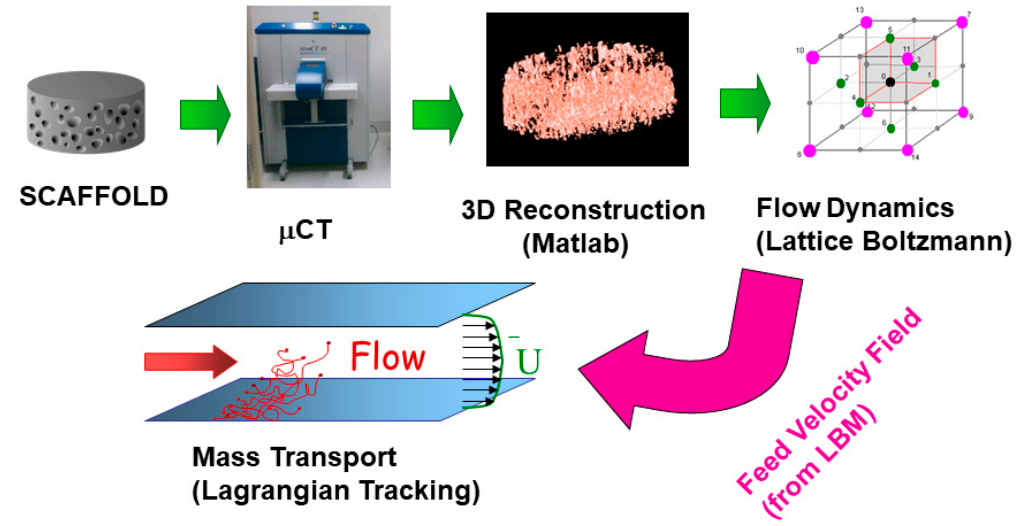
Figure 1. The image-based modeling methodology used in this work; scaffolds are scanned in 3D via high resolution µ CT, reconstructed in silico, and the resulting geometries are used by the LBM and rLST solvers.